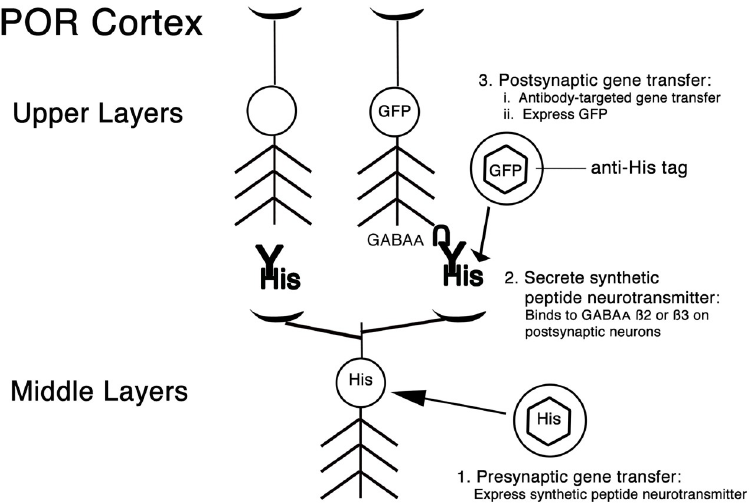
Fig 1. The strategy for delivering different genes into pre- or post-synaptic neurons in POR cortex connected by GABAergic synapses that contain GABA A ß2 or ß3 subunits. This strategy contains three steps: Step 1 is the presynaptic gene transfer: This gene transfer uses an injection site in the middle layers of POR cortex, and the gene transfer uses standard procedures. This vector expresses a synthetic peptide neurotransmitter from a GABAergic- specific promoter, the GAD67 promoter. The synthetic peptide neurotransmitter, abbreviated His within a HSV-1 vector particle (hexagon surrounded by a circle), contains three domains: i) a DCV sorting domain, ii) a ScFv anti- GABA A ß2 or ß3, and iii) the His tag. Step 2 is release of the synthetic peptide neurotransmitter (shown as His-Y, Y indicates the ScFv domain), followed by binding to GABA A receptors (shown as inverted U) on the postsynaptic neuron on the right side of the Fig. Step 3 is the postsynaptic gene transfer: This gene transfer uses an injection site is in the upper layers of POR cortex and is selective for the postsynaptic neurons that have bound the synthetic peptide neurotransmitter: The gene transfer uses antibody-mediated targeting. These vector particles contain a modified HSV- 1 glycoprotein fused to the IgG binding domain from Staphylococcus A protein, and bound to anti-His tag antibody (in the top right of the Figure: HSV-1 vector particle, hexagon surrounded by a circle; modified HSV-1 glycoprotein, horizontal line from HSV-1 vector particle to anti-His tag). Complexes of these vector particles and anti-His tag antibodies are injected, and these complexes bind to the His tag on the synthetic peptide neurotransmitter, bound to GABA A ß2 or ß3 subunits on specific postsynaptic neurons. To support assays for gene transfer to connected neurons, the postsynaptic vector expresses a dendrite-targeted GFP from a pan-neuronal promoter, the INS-TH-NFH promoter. This system supports highly specific gene transfer to neurons connected by GABA A ß2 or ß3 subunit- containing synapses: As shown in the left column, axon collaterals from transduced neurons will release the synthetic peptide neurotransmitter at other synapses, but if the postsynaptic neuron lacks GABA A ß2 or ß3 subunits, that postsynaptic neuron will not be transduced.